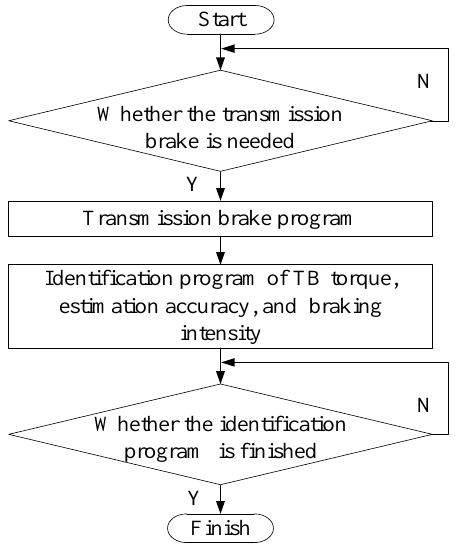
Figure 7. Flow of TB parameter identification.